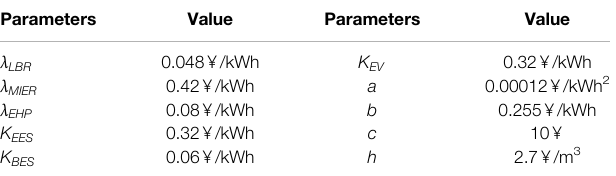
TABLE 1 | Cost parameters of MEG system.